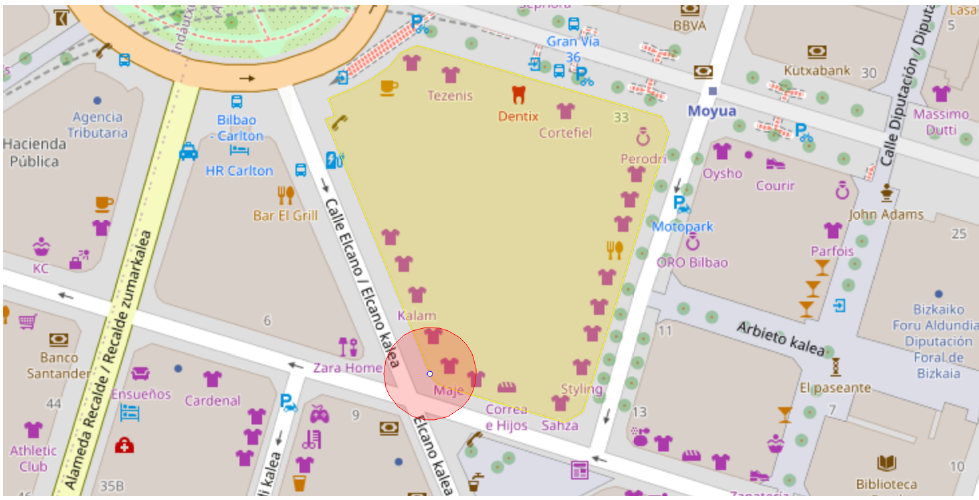
Figure 17. Initial